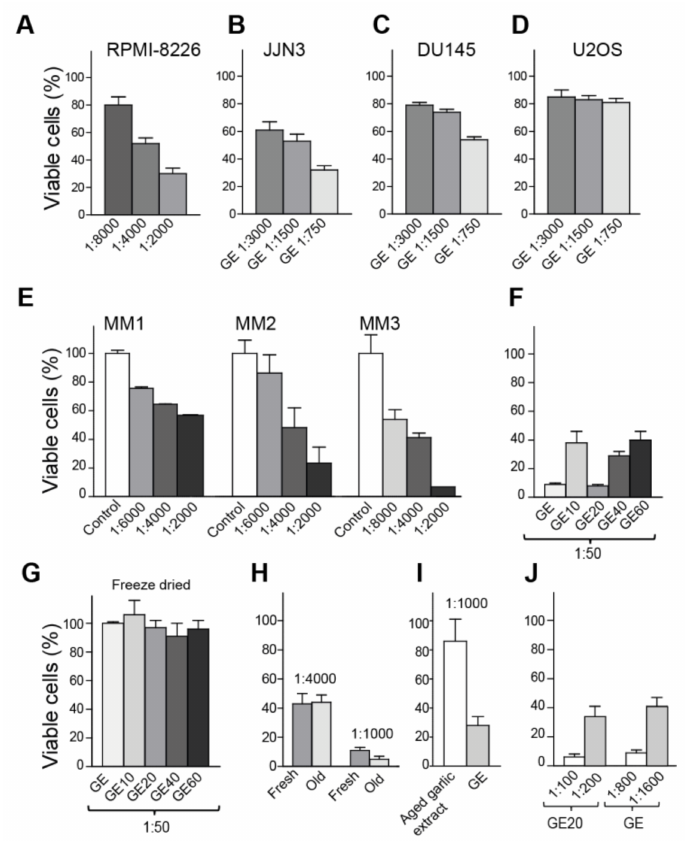
Figure 1. Volatile compounds in garlic extract (GE) inhibit growth of multiple cancer cells. ( A – D ) Viability measured by MTT-assay on day four, after the addition of three dilutions of GE for ( A ) RPMI-8226 (multiple myeloma (MM)), ( B ) JJN3 ((MM), ( C ) DU145 (prostate cancer), and ( D ) U2OS (osteosarcoma). The percentage viabilities are relative to vehicle-treated cells. ( E ) Viability of non-proliferating primary MM cells co-cultured with bone marrow stromal cells (BMSC-assay), measured on day three. MM cells from three patients (MM1-MM3). Averages from two parallel samples with SD are shown. ( F – J ) Viability (MTT) measured relative to vehicle treated cells in JJN3 cells ( F ) after the addition of unfractionated GE and fractionated GE extracts (GE10–GE60) on day three, ( G ) after the addition of freeze-dried and re-suspended GE and GE10-GE60 on day three, ( H ) after